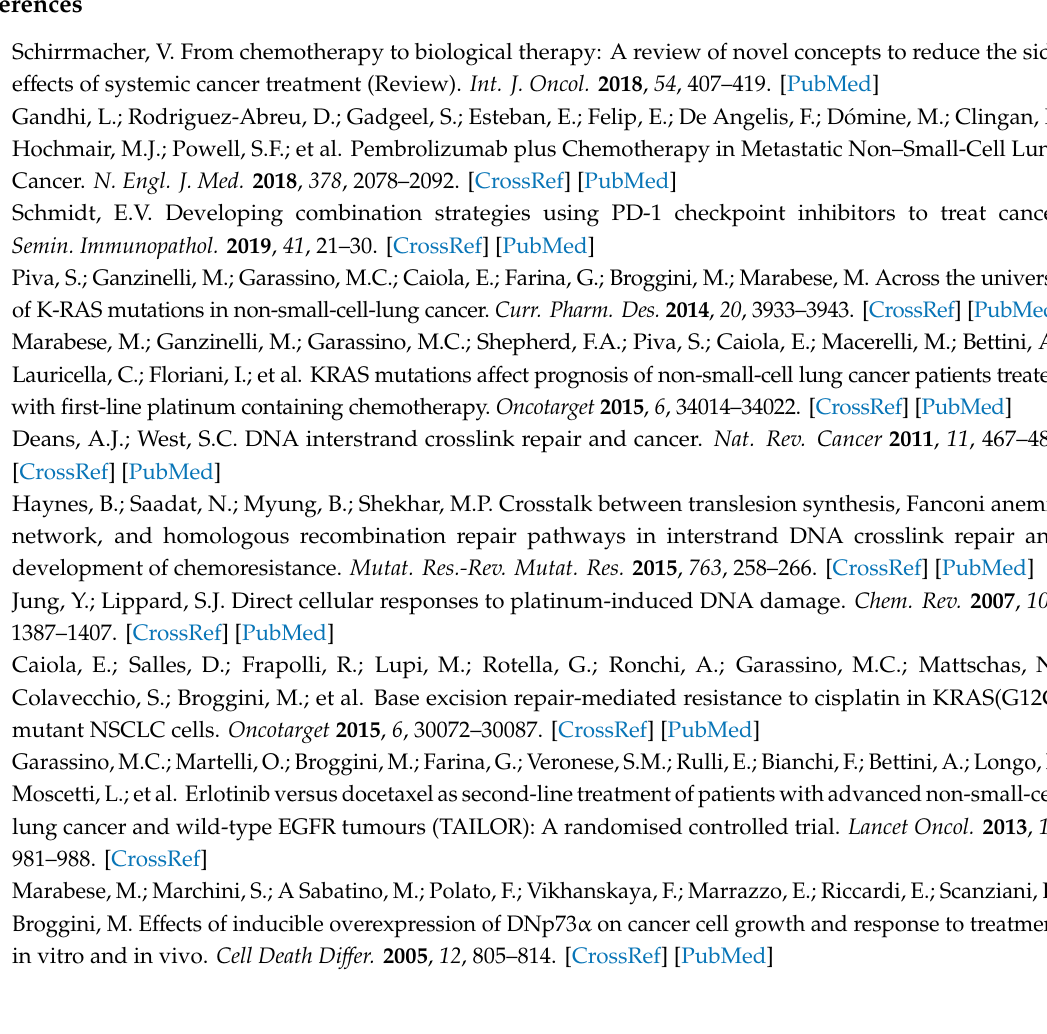
Figure S1: Negative and positive DNA polymerase β staining tissues magnified